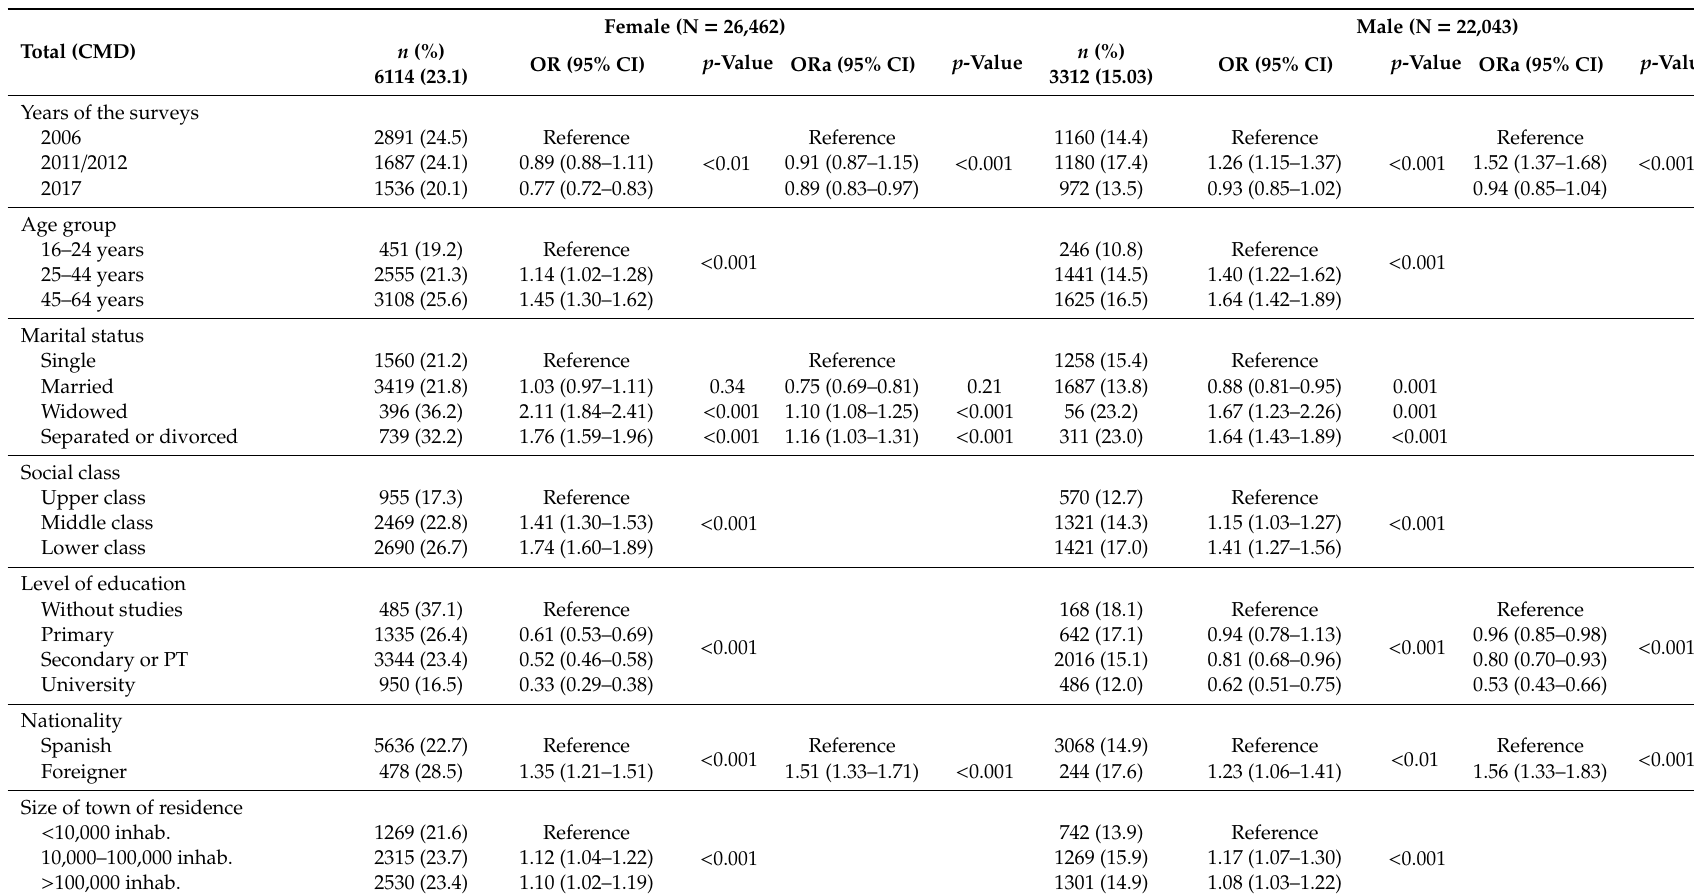
Table 2. Association between common mental disorders and sociodemographic, clinical and lifestyle habits variables and perception of environmental problems by gender of adults aged from 16 to 64 years in Spain (N = 48,505)